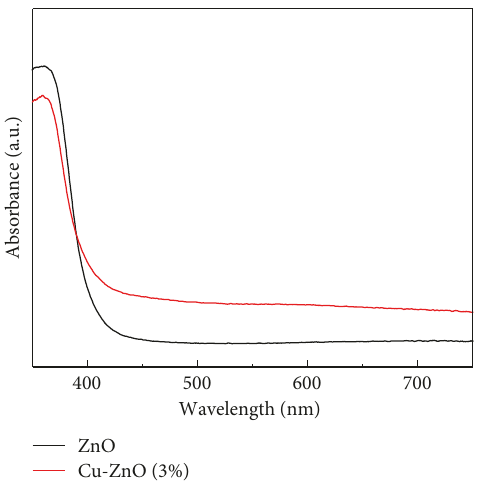
Figure 5: The UV-visible spectra of the ZnO and Cu-ZnO (3%)